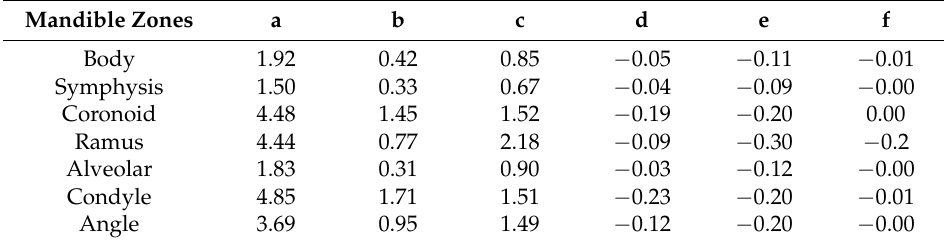
Table 6. The achieved coefficients from Response Surface Methodology (RSM) technique to predict the average von Mises stress S avg in each zone.